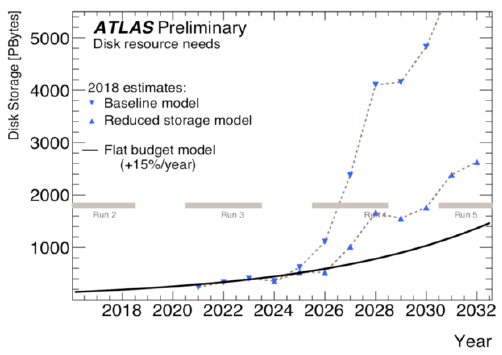
Fig. 1 Projection of the ATLAS data volume at the HL-LHC